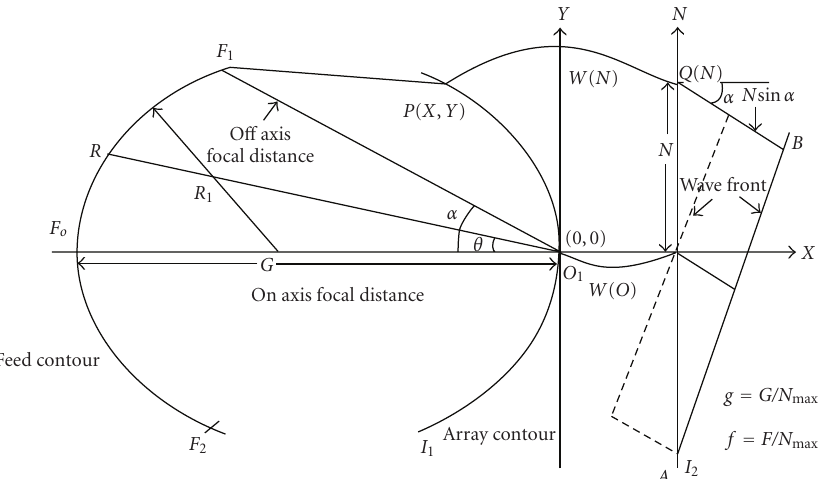
Figure 1: Elliptically focused